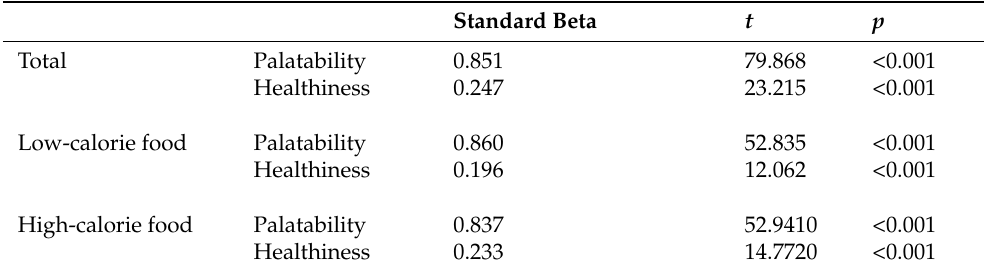
Table 5. Image-based eating decisions ( β